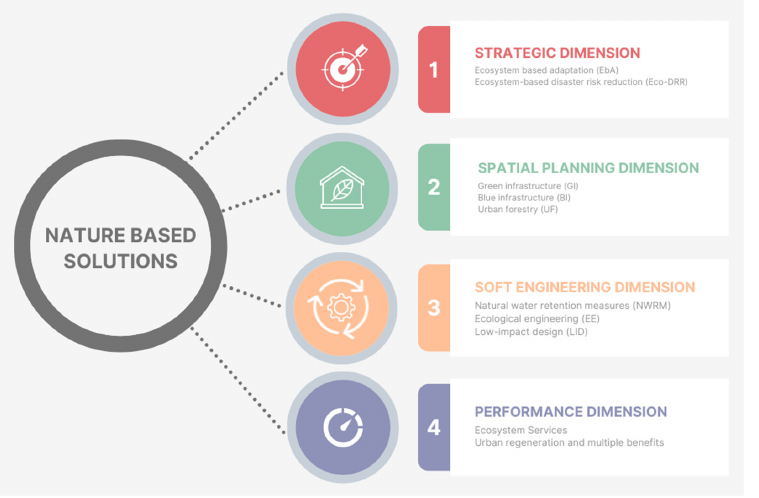
Figure 1. Overview of nature-based concepts and their relationship to existing key concepts. Adapted from [25,28].